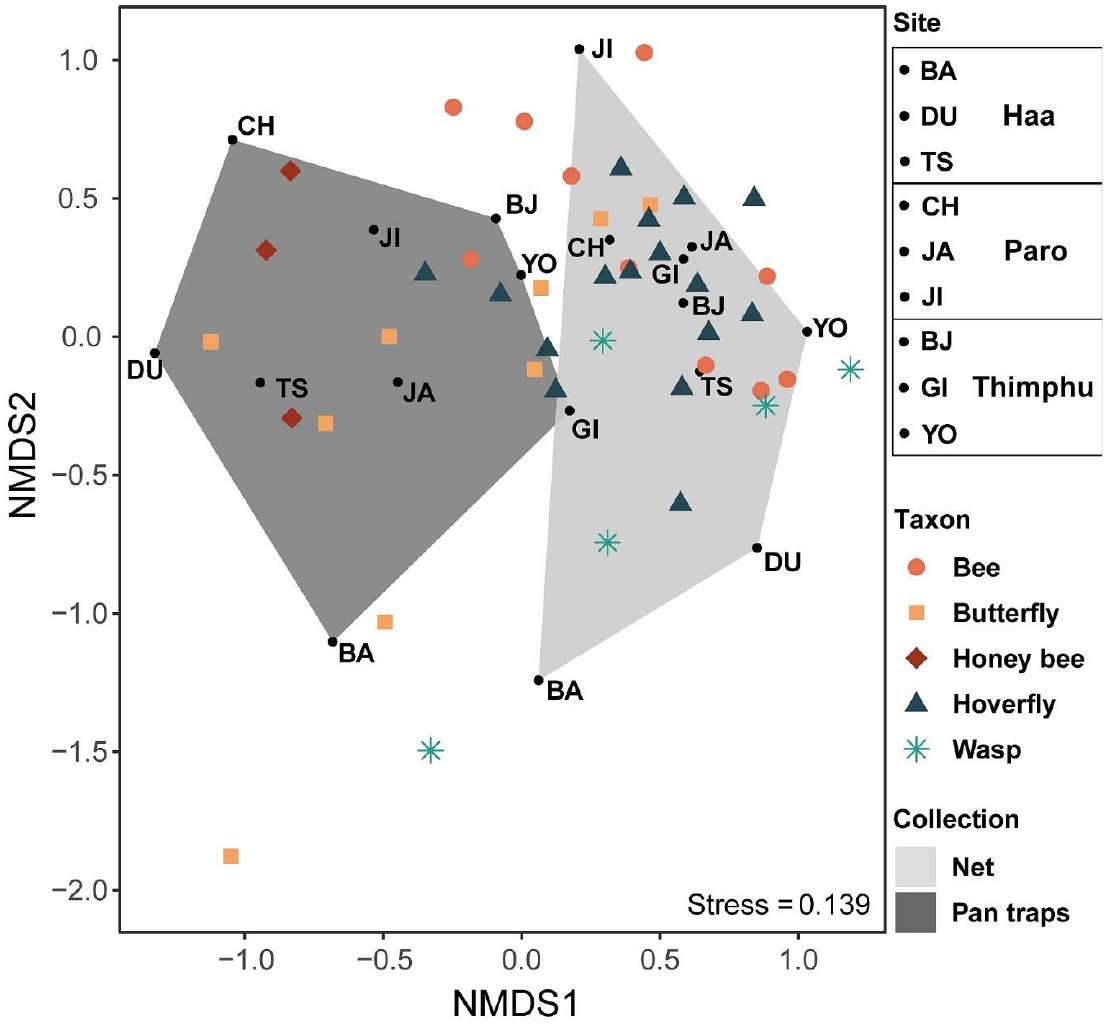
Figure 5 Non-metric multidimensional scaling (NMDS) showing the variability in community composition by site and collection